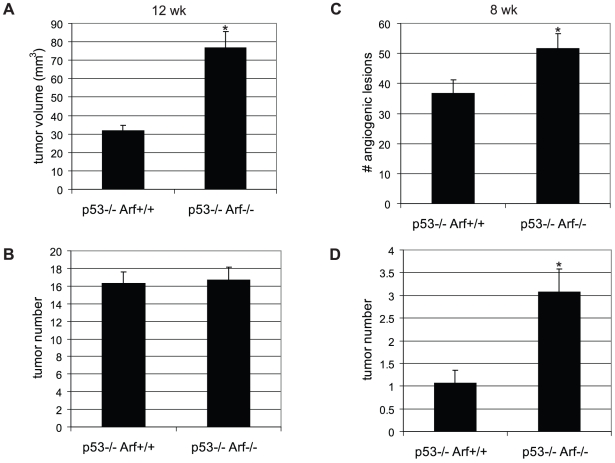

Arf knockout accelerates tumor progression in part via p53-independent mechanisms.(A, B) Arf knockout in RIP-Tag2; p53−/− mice results in an increased tumor burden (A; p<0.0001) without affecting tumor number (B) at 12 weeks of age. Mean values +/−SEM from 19 (p53−/−; Arf+/+), or 14 (p53−/−; Arf−/−) mice/group are indicated. Mann-Whitney test for statistical significance. (C, D) Increased angiogenic islet numbers (C; p = 0.04) and tumors (D; p = 0.002) in RIP-Tag2; p53−/−; p19Arf−/− mice at 8 weeks of age. Mean values +/−SEM from 15 (p53−/−; Arf+/+), or 13 (p53−/−; Arf−/−) mice/group are indicated. Mann-Whitney test for statistical significance.